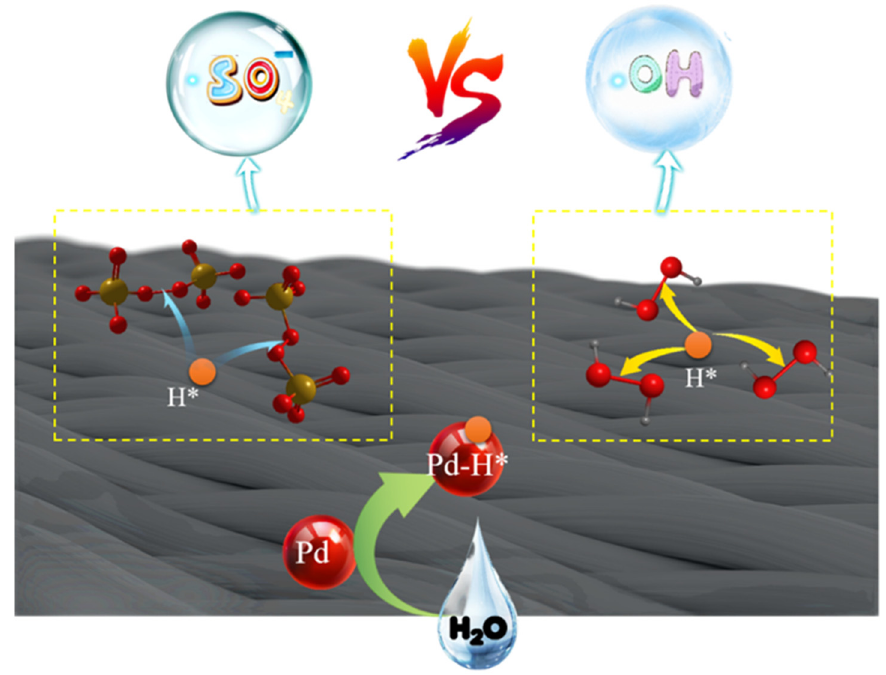
Figure 9. A schematic diagram shows the catalytic mechanism of Pd/C@CF in degradation process of organic